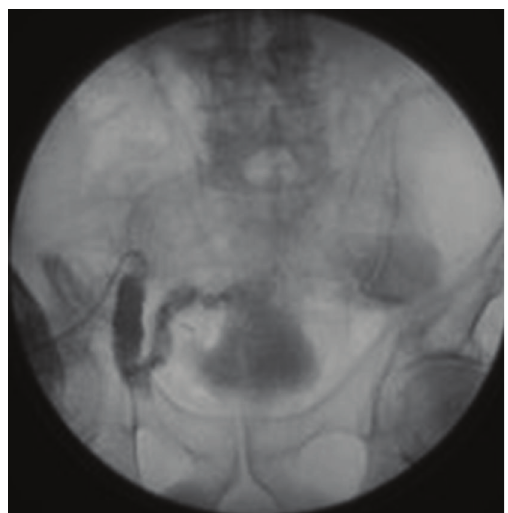
Figure 2: Loopogram demonstrating proximal contrast leakage from the conduit without visualization of either ureter.